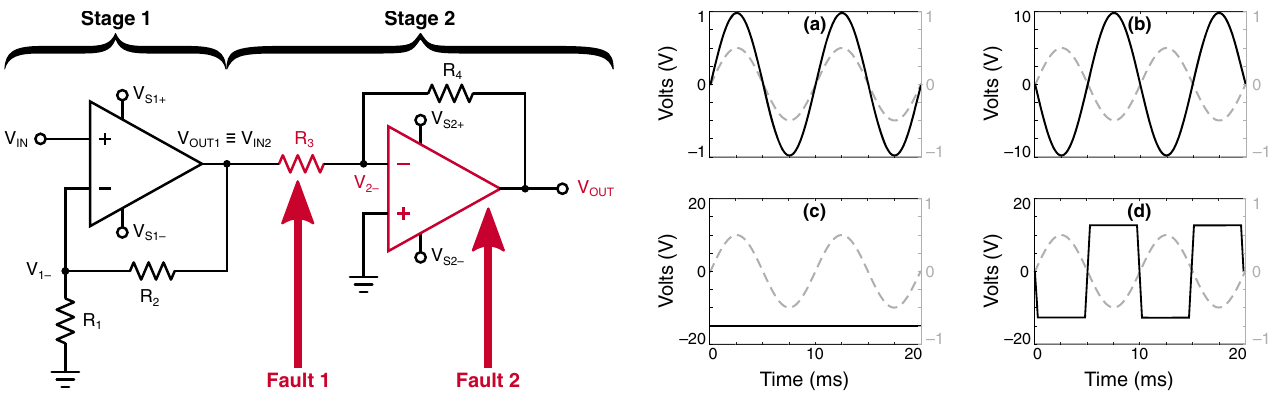
FIG. 3. (Left) Schematic diagram of inverting cascade amplifier, with design elements highlighted. A comparison of nominal voltages and resistances in both functioning and malfunctioning versions of the circuit is provided in Table II. (Right) Theoretical output signals of the inverting cascade amplifier with an input signal of amplitude 100 mVand frequency 100 Hz. In all plots, the vertical scales on the left and right respectively correspond to the output signals of stages 1 or 2 (solid black curves) and the input signal to stage 1 (dashed gray curves). Plots (a) and (b) show the outputs of stages 1 and 2, respectively, in a functioning circuit. Plot (c) shows the output of stage 2 due to the faulty op-amp, and plot (d) shows the output of stage 2 when both op-amps are functional but the input signal is sufficiently large that clipping